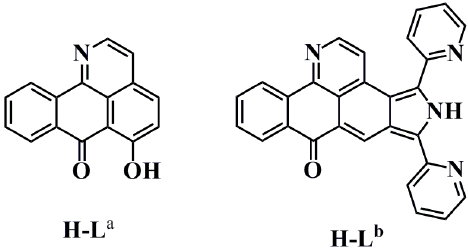
Figure 1. Chemical structure of oxoisoaporphine ligands H-L a (6-hydroxyl-oxoisoaporphine) and H-L b (6-di(2-pyridinyl)benzo[ h ]isoindolo[4,5,6- de ]quinolin-8(5 H )-one).